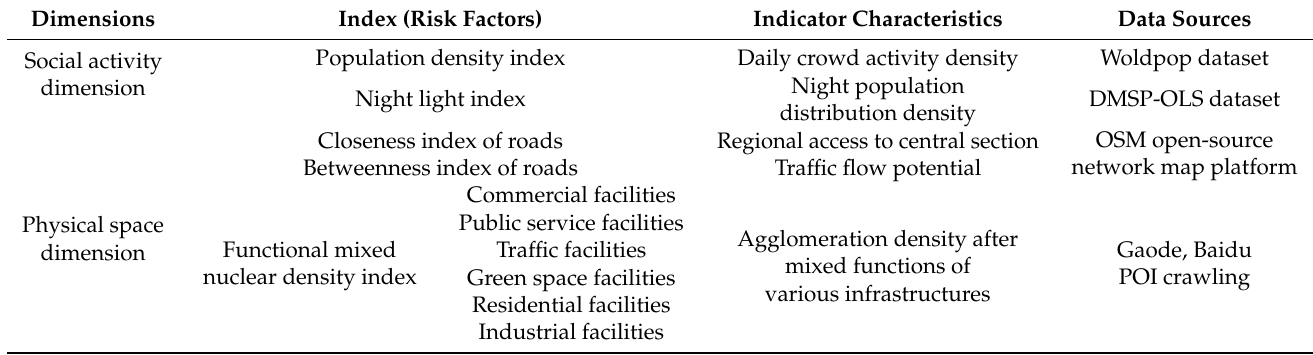
Table 1. Disaster Risk Indicators.